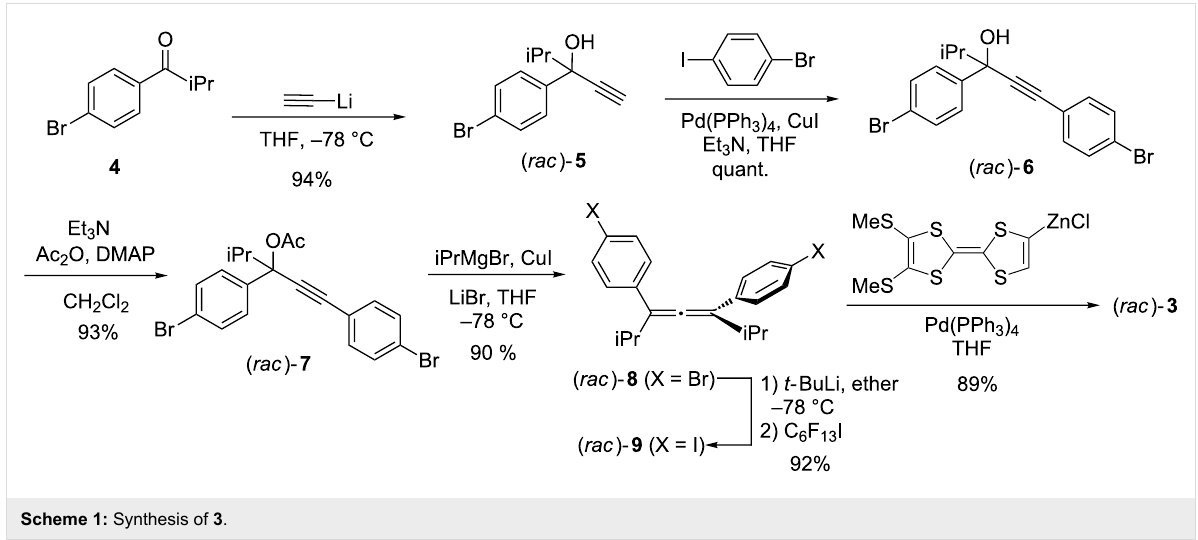
solution under daylight. The chirality of an allene is configura- tionally firm in general, because the barrier of the rotation of the allenic double bonds is quite high ( Δ G ‡ = 180 kJ mol − 1 for CH 3 CH=C=CHCH 3 ) [11]. In contrast, several allenes directly connected with electron-donating groups occasionally under- went photoracemization [12,13]. Although the mechanism of the photoracemization is not clear, a comparative examination of the racemization rate in 1 and 2 , the latter of which is